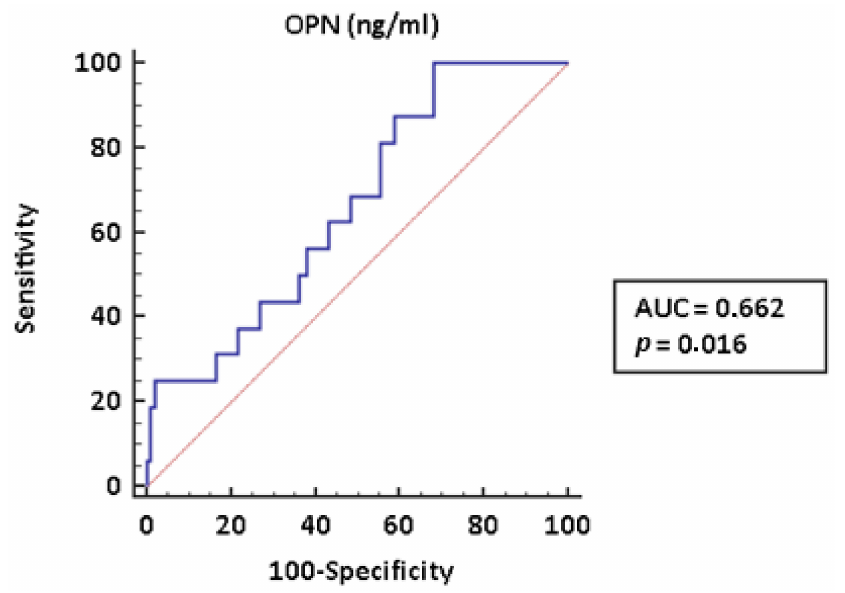
Figure 2. OPN ROC curve. Abbreviations: ROC—receiver operating characteristic; OPN—osteopontin; AUC—area under the